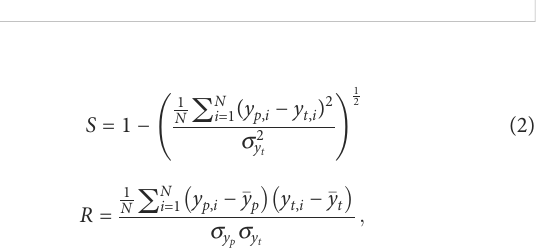
FIGURE 4 Evolution of skills with deep learning. The solid lines represent deep- learning skills with CMIP6, whereas the dotted lines (except black) represent SODA skills. The solid blue line represents the veri fi cation data, the orange line the test data, and the black dotted line represents the average of the top 10 skills using CMIP6. The green dotted line represents veri fi cation data, the red dotted line represents test data, and the pink dotted line denotes the average of the top 10 skills with